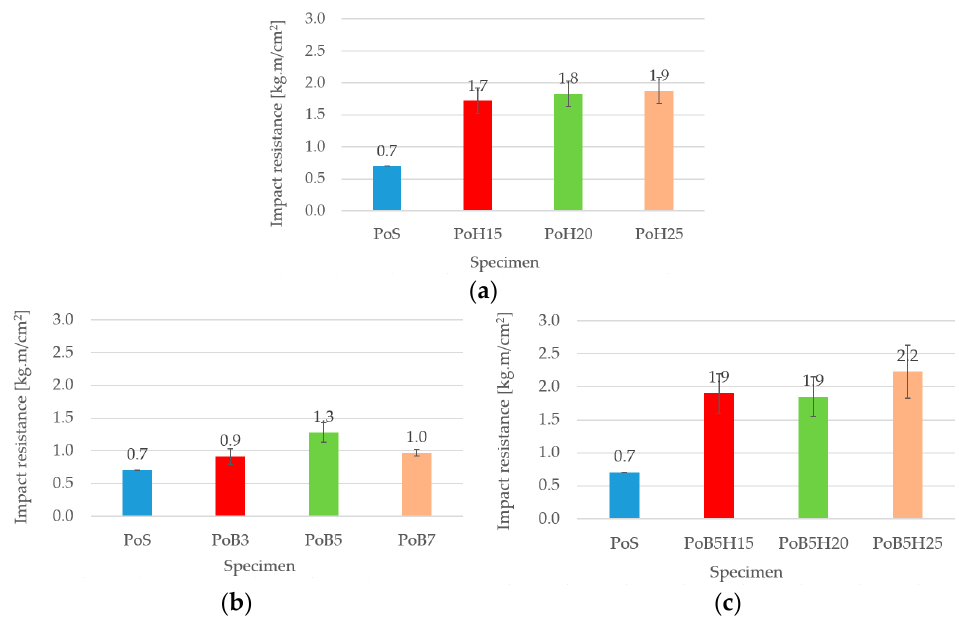
Figure 10. Impact strength of neat polymer: ( a ) polymer plus polymer samples plus 15, 20, and 25% henequen; ( b ) polymer and polymer plus bentonite 3, 5, and 7%, respectively; ( c ) polymer plus 15% henequen and 5% bentonite; polymer plus 20% henequen and 5% bentonite; and polymer plus 25% henequen and 5% bentonite, respectively.